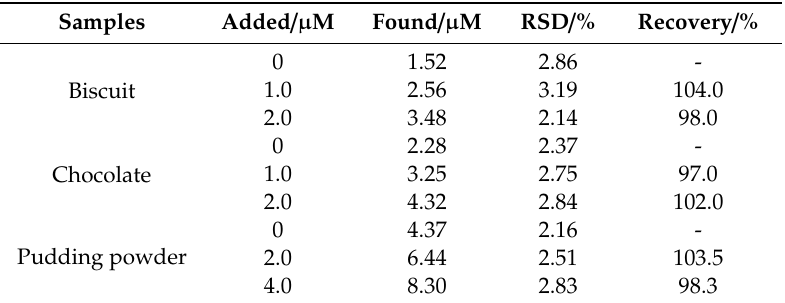
Table 3. Determination results of vanillin in food samples.